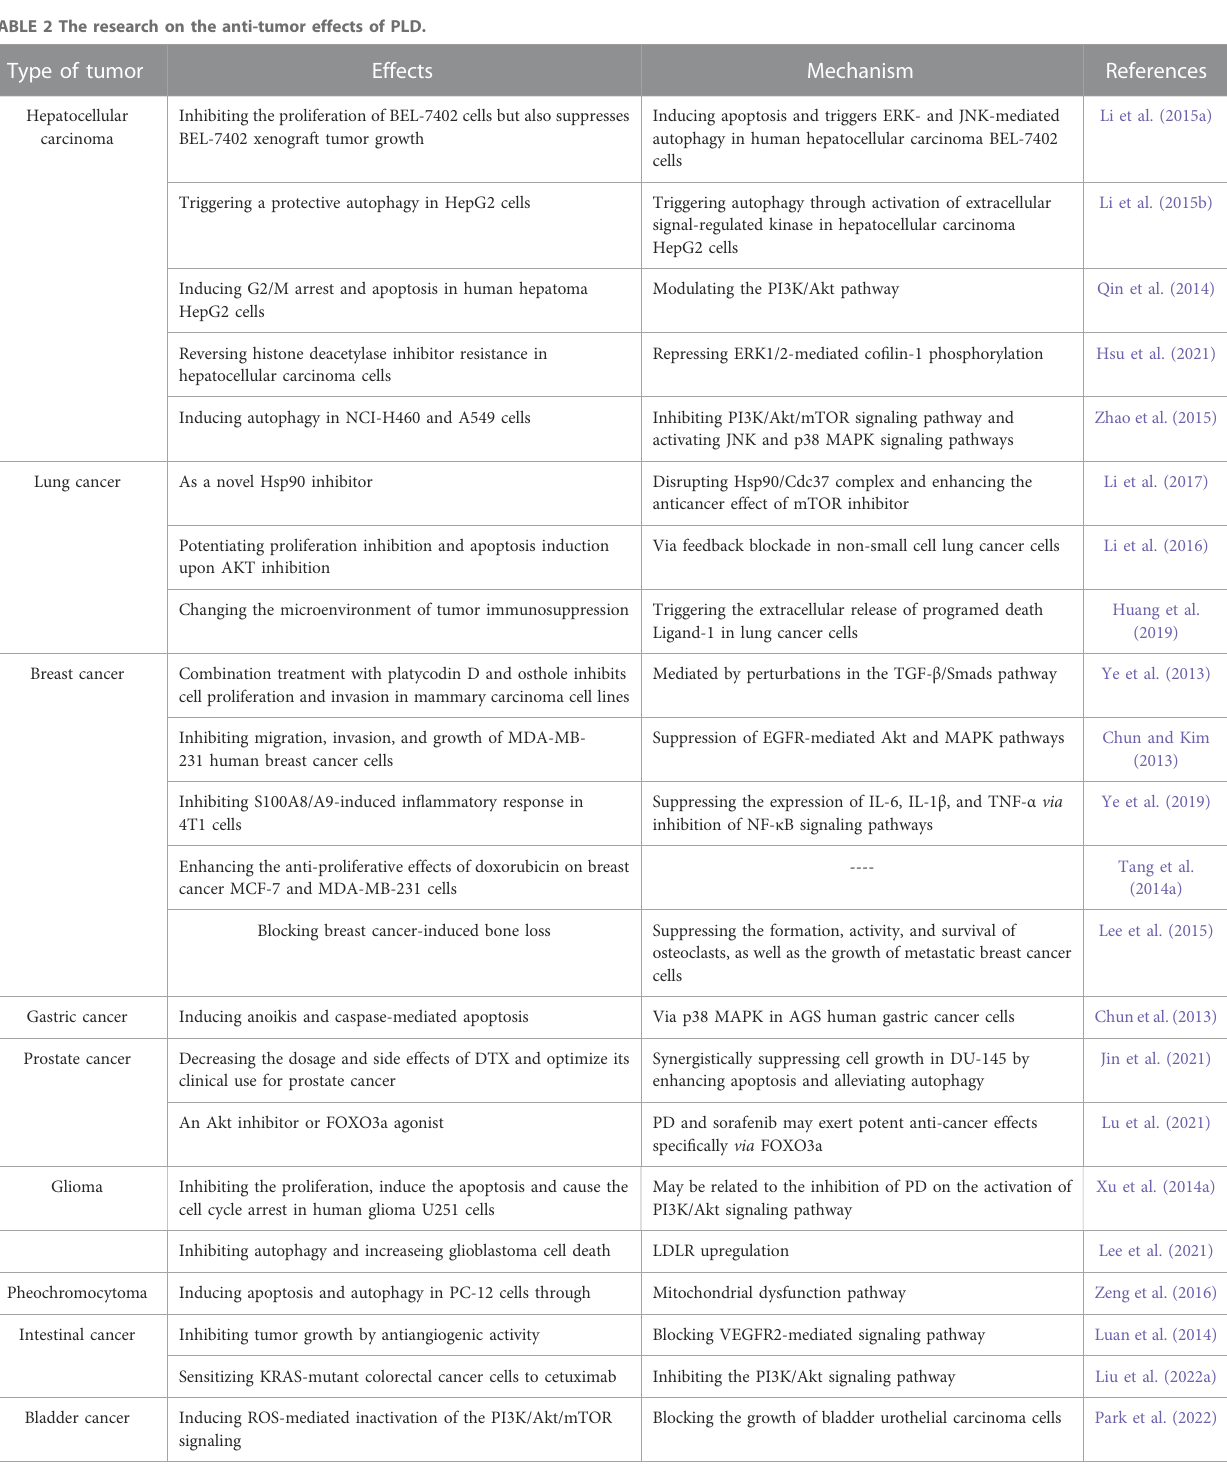
TABLE 2 The research on the anti-tumor effects of